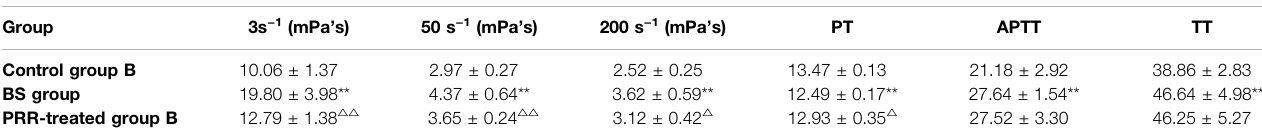
TABLE 3 | Comparison of hemorheological indices and coagulation indices among different groups of the rats in BS stage ( ‾ x ± s, n = 10).